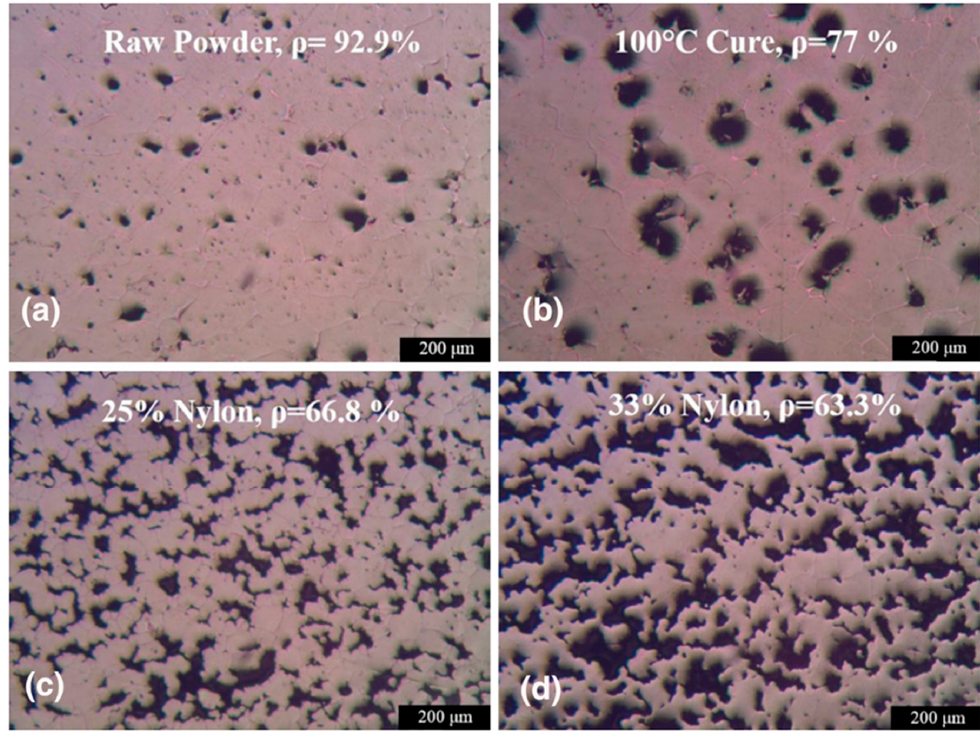
Figure 14. Porosity on the cross section of the samples made by feedstock materials: ( a ) Raw 316L < 22 µm, ( b ) agglomerates cured at 100 °C, ( c ) 25% Nylon + 316L, and ( d ) 33% Nylon + 316L [106] .